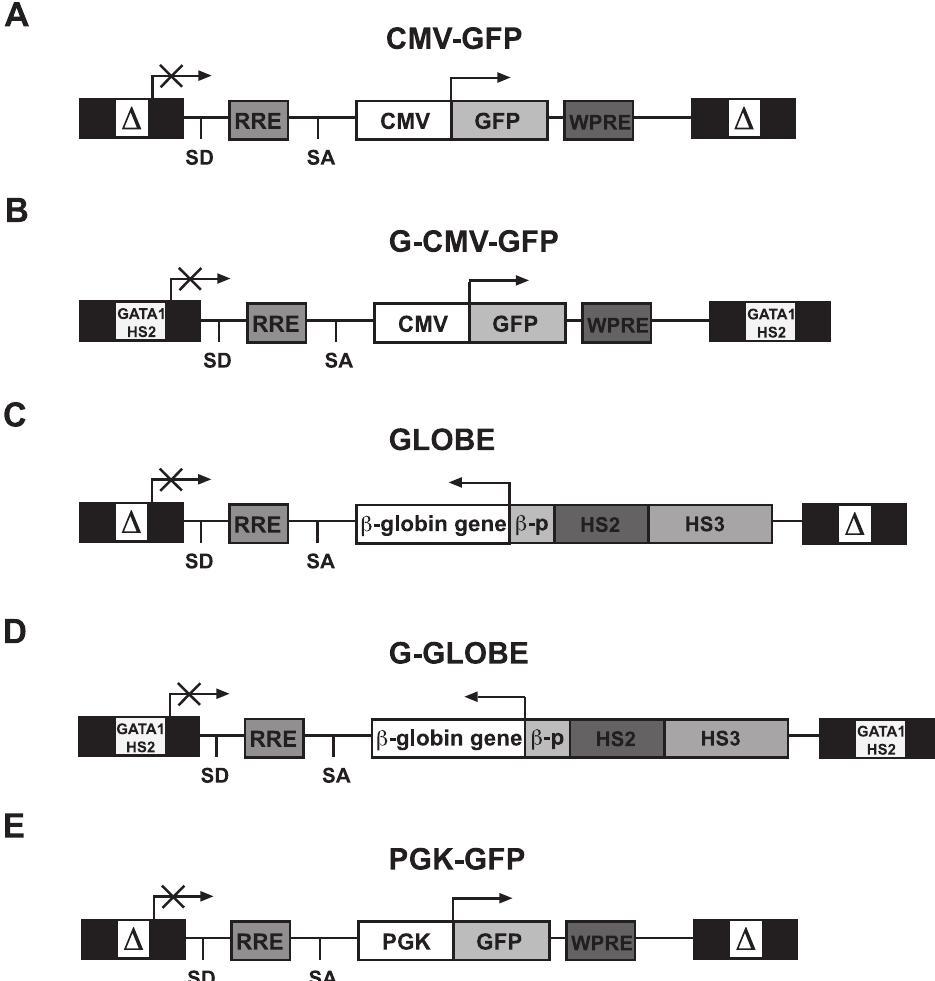
Figure 1. Structure of CMV-GFP, G-CMV-GFP, GLOBE, G-GLOBE and PGK-GFP lentiviral vectors. (A–B) Schematic map of the CMV-GFP and G-CMV-GFP vectors in their proviral form. In both vectors, the CMV promoter drives the expression of a GFP transgene. In the CMV-GFP vector, the GATA1 -HS2 enhancer was inserted into the self-inactivated LTRs (sin-18 LTRs) carrying 400 bp deletion in HIV U3 region (G sin-18 LTR). The rev- responsive element (RRE), the splice donor site (SD), the splicing acceptor site (SA), the central polypurine tract (cPPT), the woodchuck post- regulatory element (WPRE) are shown. (C) Schematic representation of the b -globin expressing G-GLOBE. The sin-18 LTR, RRE, SD, SA, cPPT, the human b -globin gene, the 2 265/ + 50 b -globin promoter ( b p) and the human LCR Dnase I hypersensitive sites HS2 and HS3 are shown. (D) Schematic representation of the b -globin expressing G-GLOBE vector. The GATA1 -HS2 element was inserted into the self-inactivated LTRs (G sin 2 18 LTR). (E) Structure of the PGK-GFP lentiviral vector. A GFP transgene is under the control of the human phospoglycerate kinase promoter